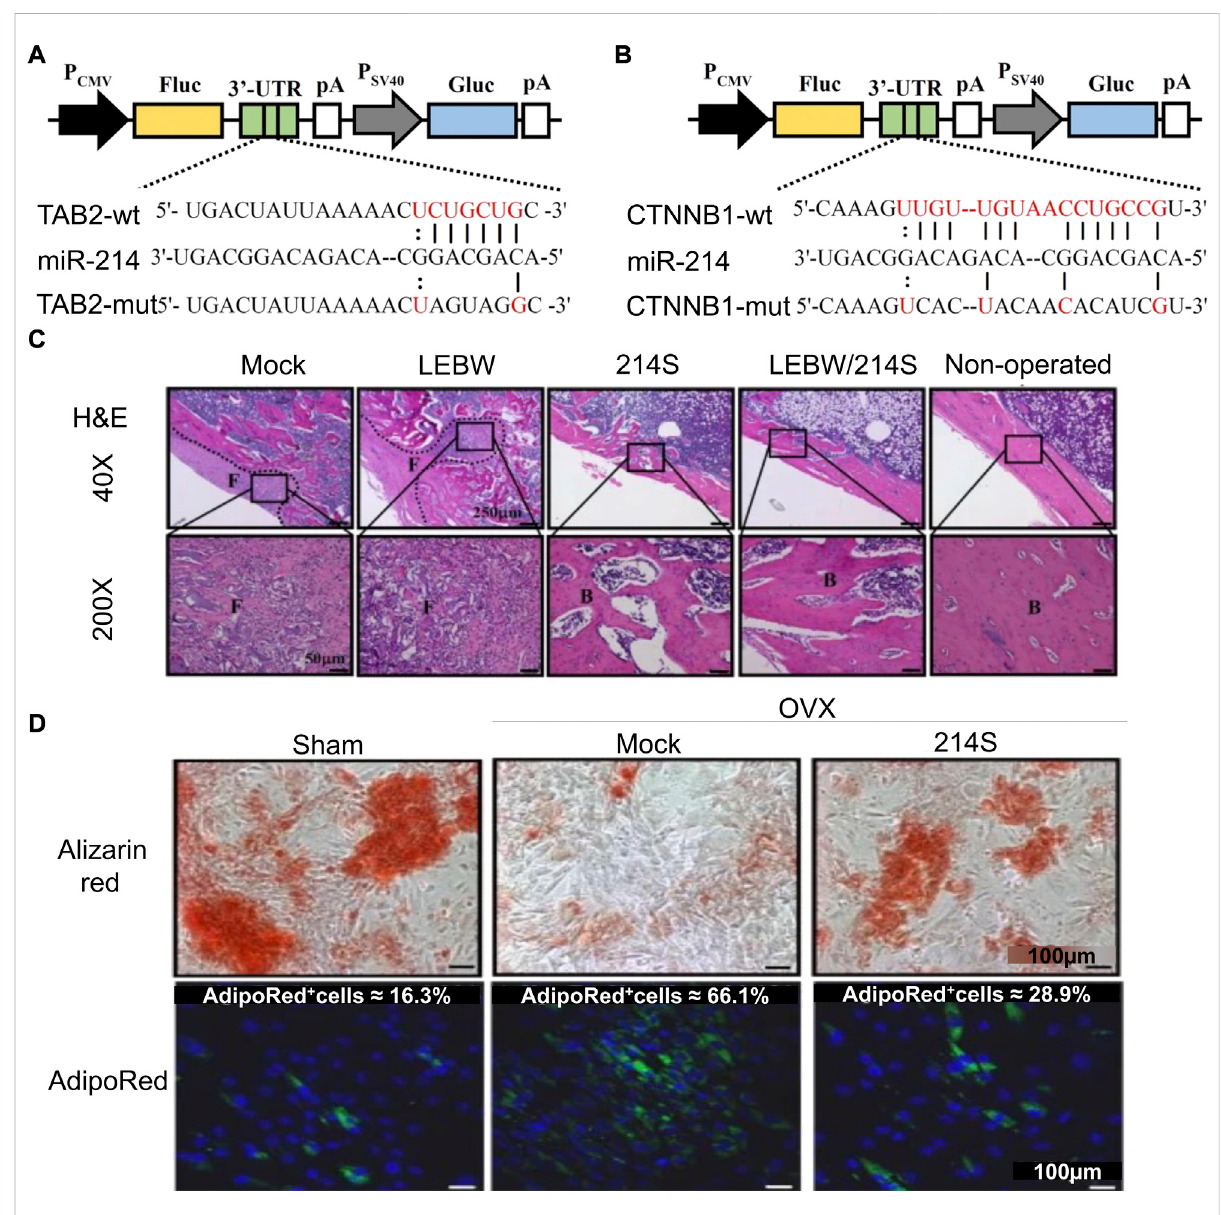
FIGURE 1 Mixed baculovirus carrying the miR-214 sponge sequence promotes osteogenic differentiation of ASCs (Li et al., 2017). (A,B) Schematic diagrams of four reporter gene plasmids were constructed to express Gaussia luciferase (Gluc) and fi re fl y luciferase (Fluc). At the 3 ′ -UTR site of Fluc, there were wild-type or mutant TAB2 (TAB2-wt or TAB2-mut) or CTNNB1 (CTNNB1-wt or CTNNB1-mut) sequences. (C) H&E staining was performed 5 weeks after femoral epiphyseal segment implantation in rats. (D) Alizarin red staining (ARS) and AdipoRed staining after virus transfection of adipose stem cells from ovariectomized rats (OVX-ASCs). (Mock, transduced without BV; LEBW, sustained BMP2 expression; 214S, co-transduction of OVX-ASCs with BacECre/Bac214S; Non-operated, rats without ovariectomy; Sham, ASCs were isolated from animals without OVX; H&E, hematoxylin and eosin.) Copyright 2017. Reproduced with permission from Springer